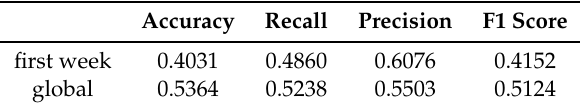
Table 4. Model evaluation scores on BTCCNY. We deployed 2 different sampling schemes. Refer to the text for